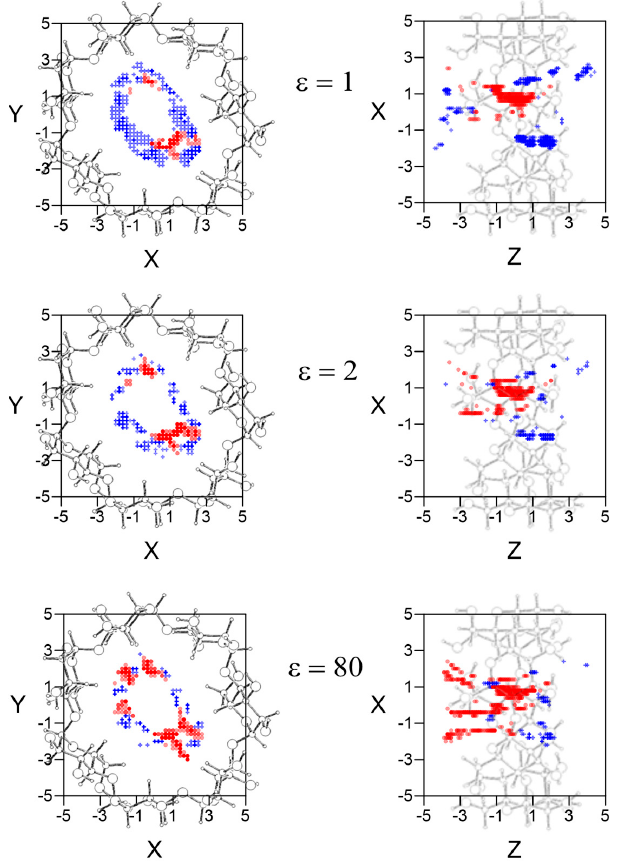
Figure 3. The projections in XY and XZ planes of the points of potential surfaces with greater differences in energy, red circles correspond to locations in which L-Ile is more stable and blue crosses those for D-Ile. The bolder the symbol, the greater difference in energy it represents. A schematic representation of the projections of β –CD is included in those planes.